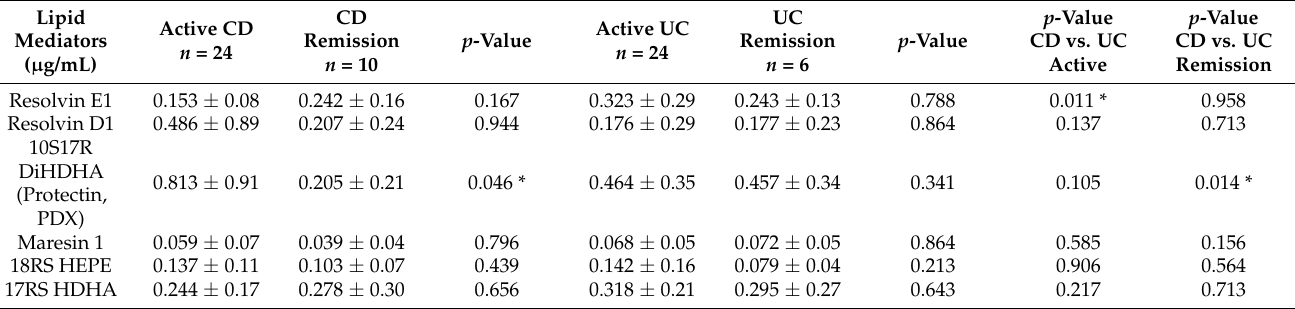
Table 2. Characteristics of lipid mediators in CD and UC groups with disease stage differentiation.